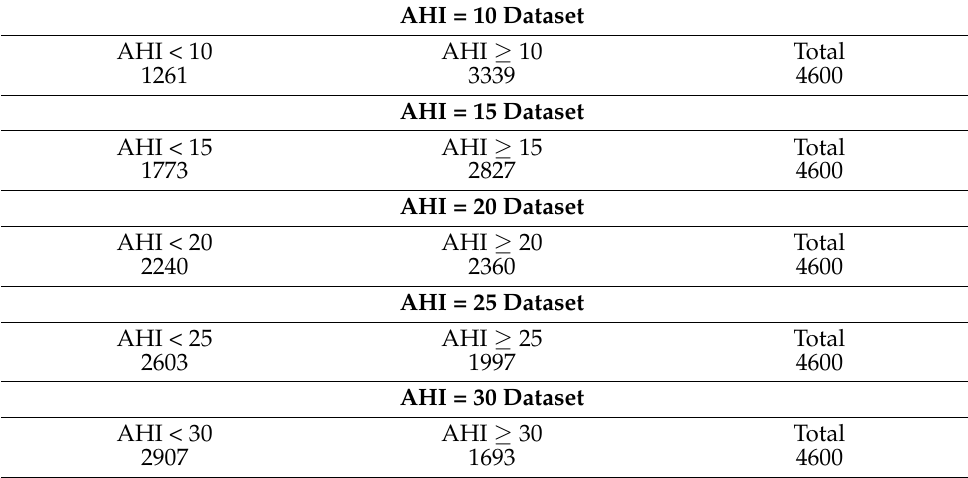
Table 5. Summary of the number of cases according to the different threshold